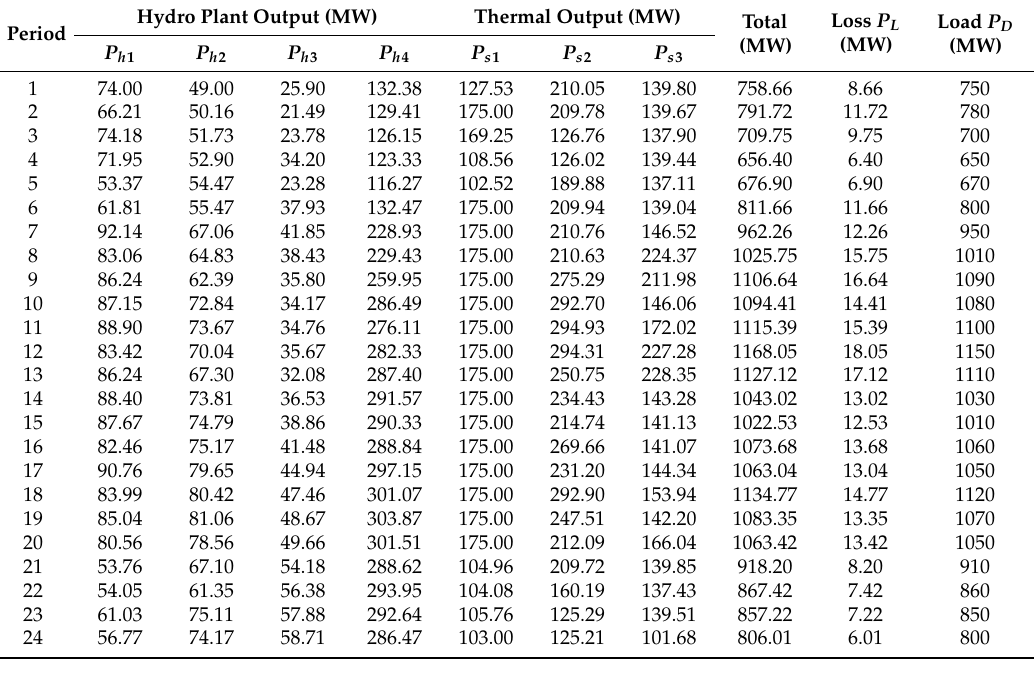
Table 7. The detailed results of Scheme 15 by PMOGA for Case 3.